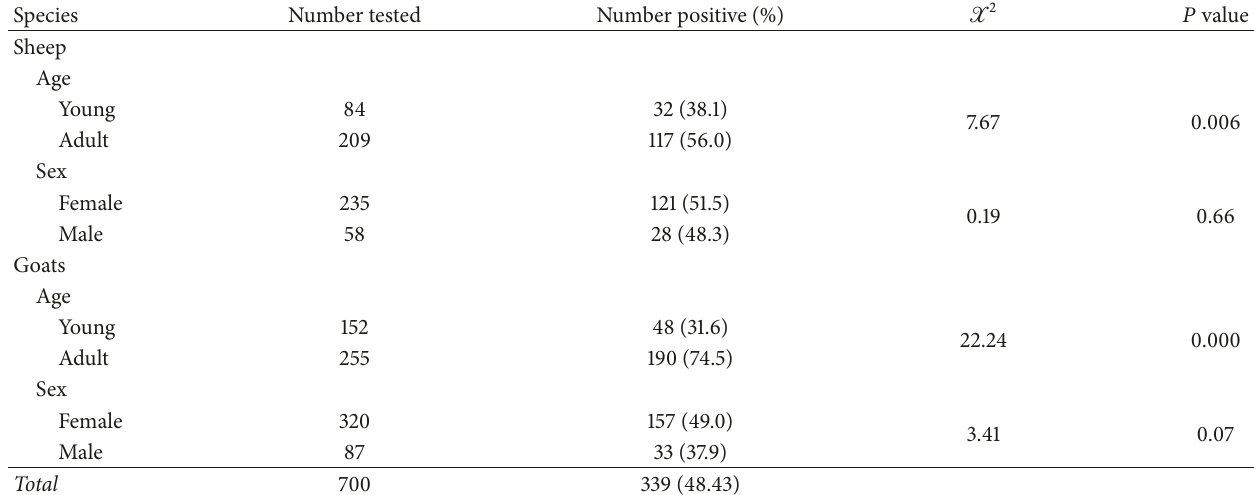
Table 2: Seroprevalence of PPR occurrence in sheep and goats for different sex and age